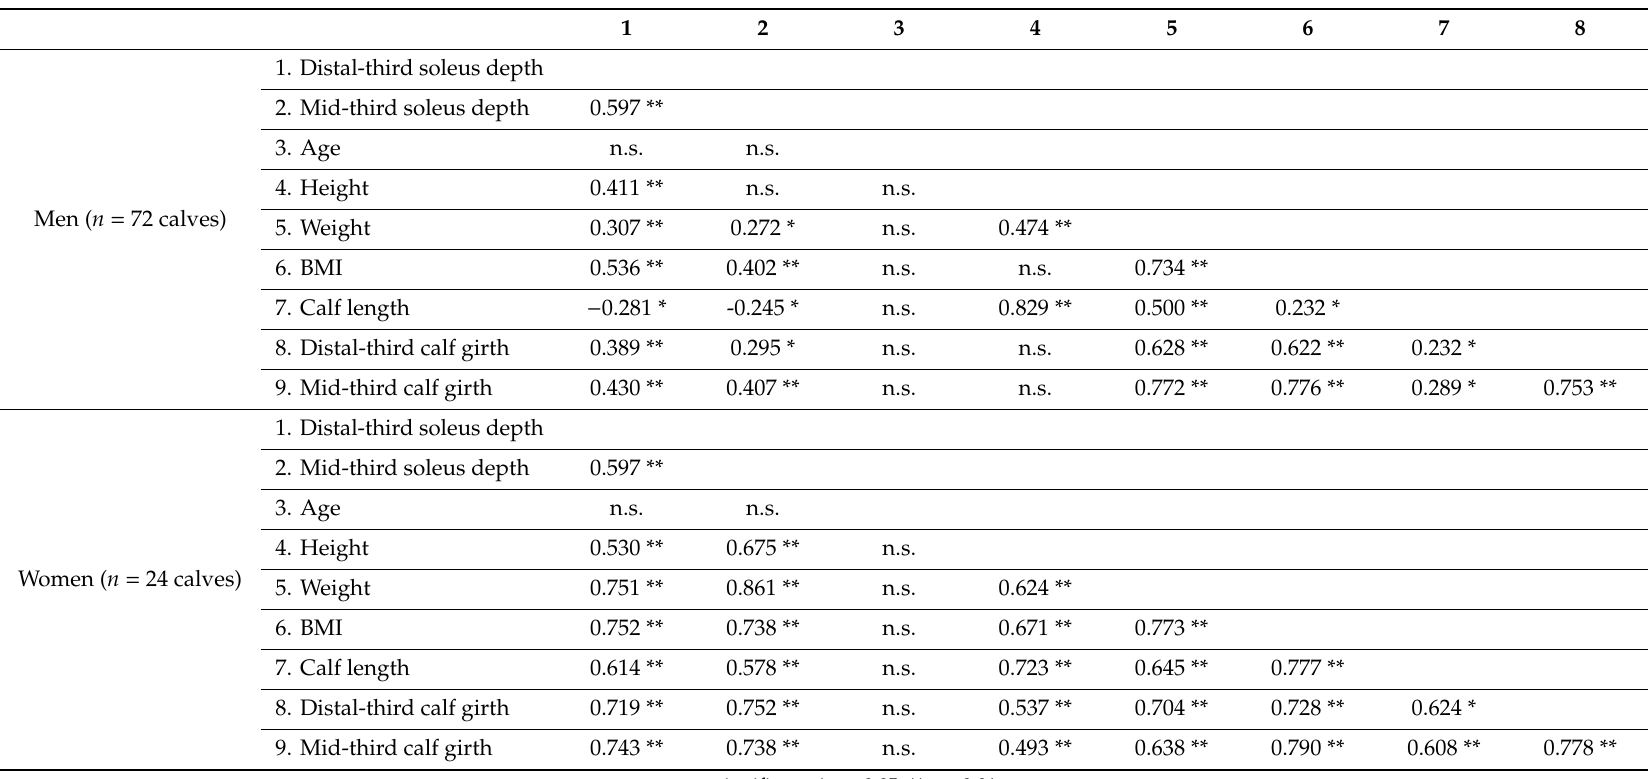
Table 2. Pearson-Product Moment Correlation